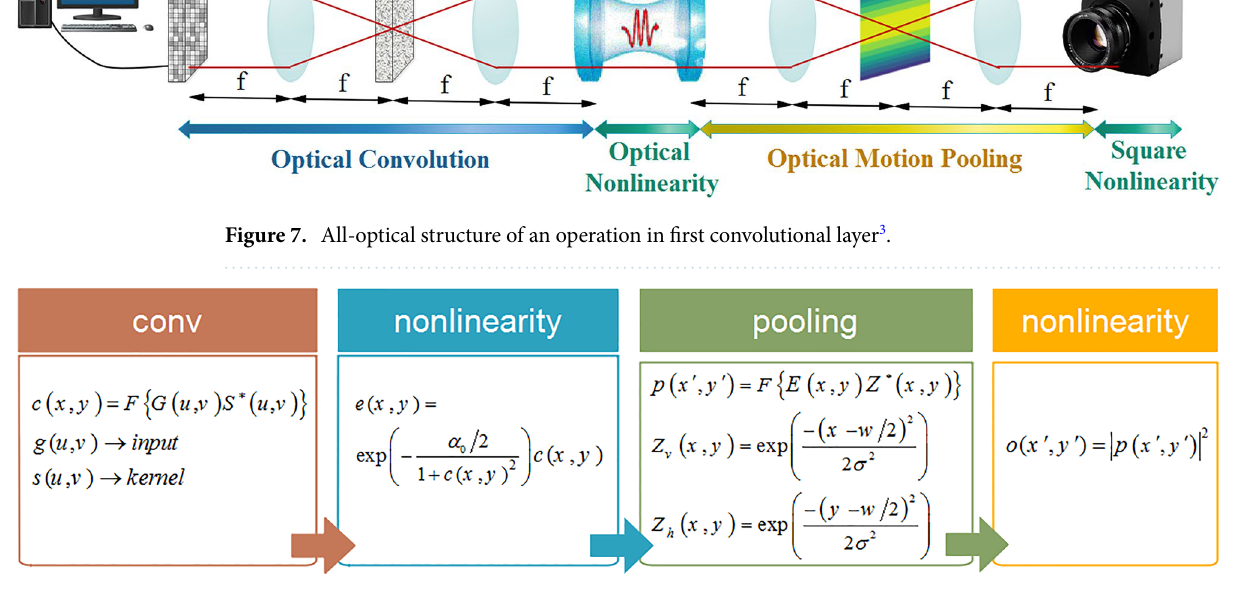
Figure 8. The mathematical function of each optical operation implemented in the proposed all-optical convolutional layer.